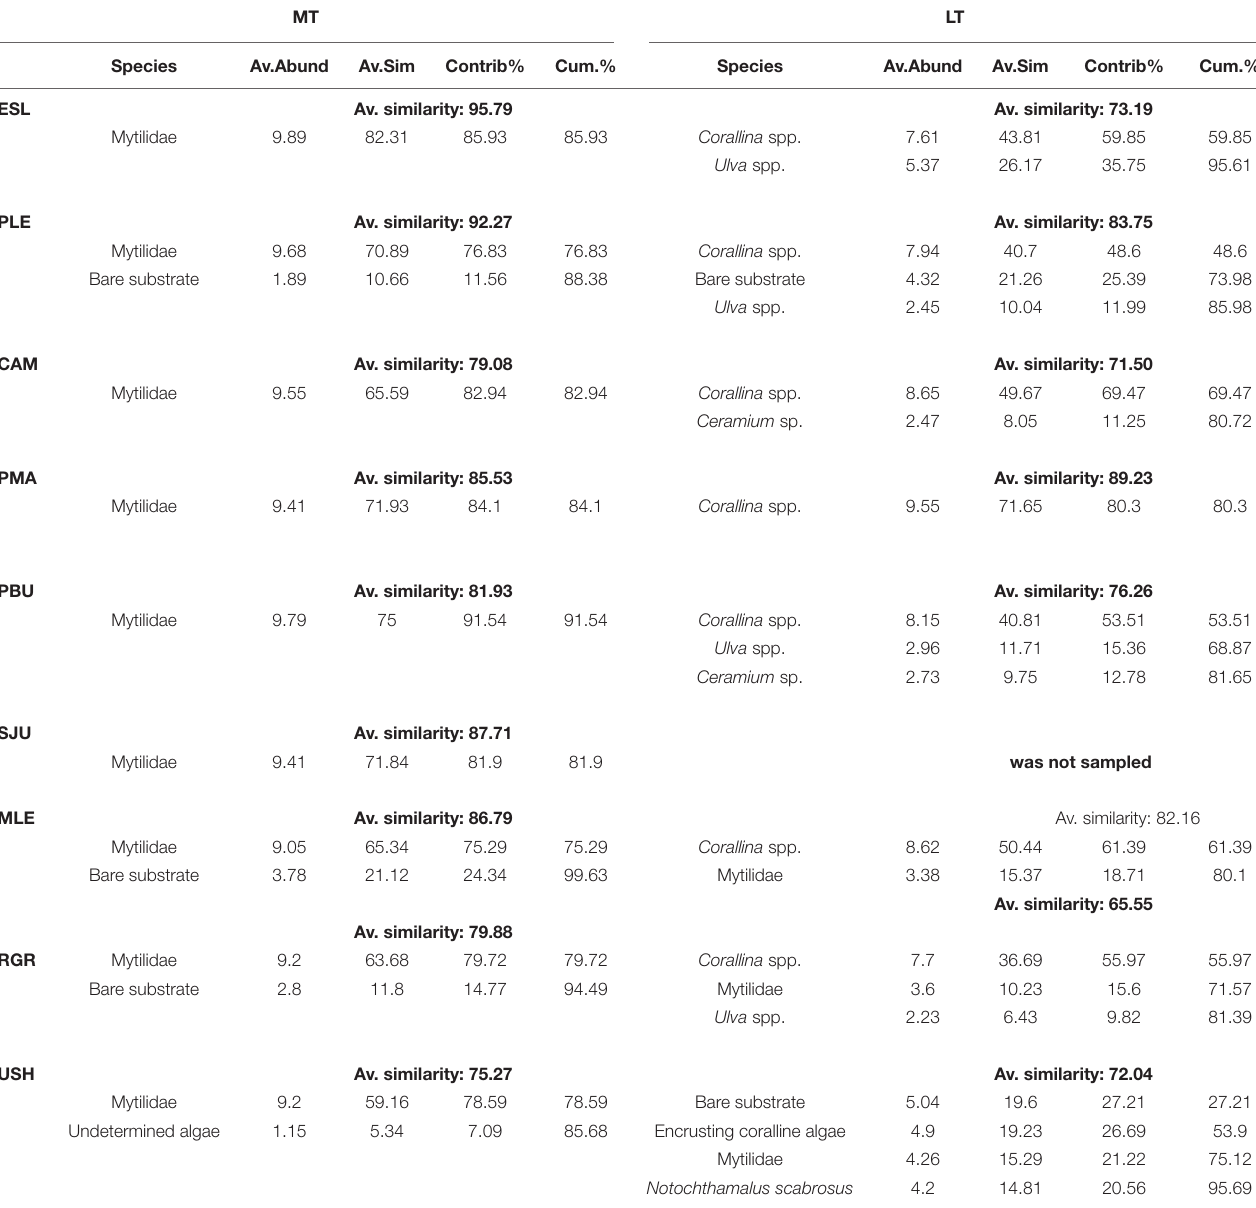
TABLE 1 | Results of SIMPER analysis for each location in the two tidal levels. MT